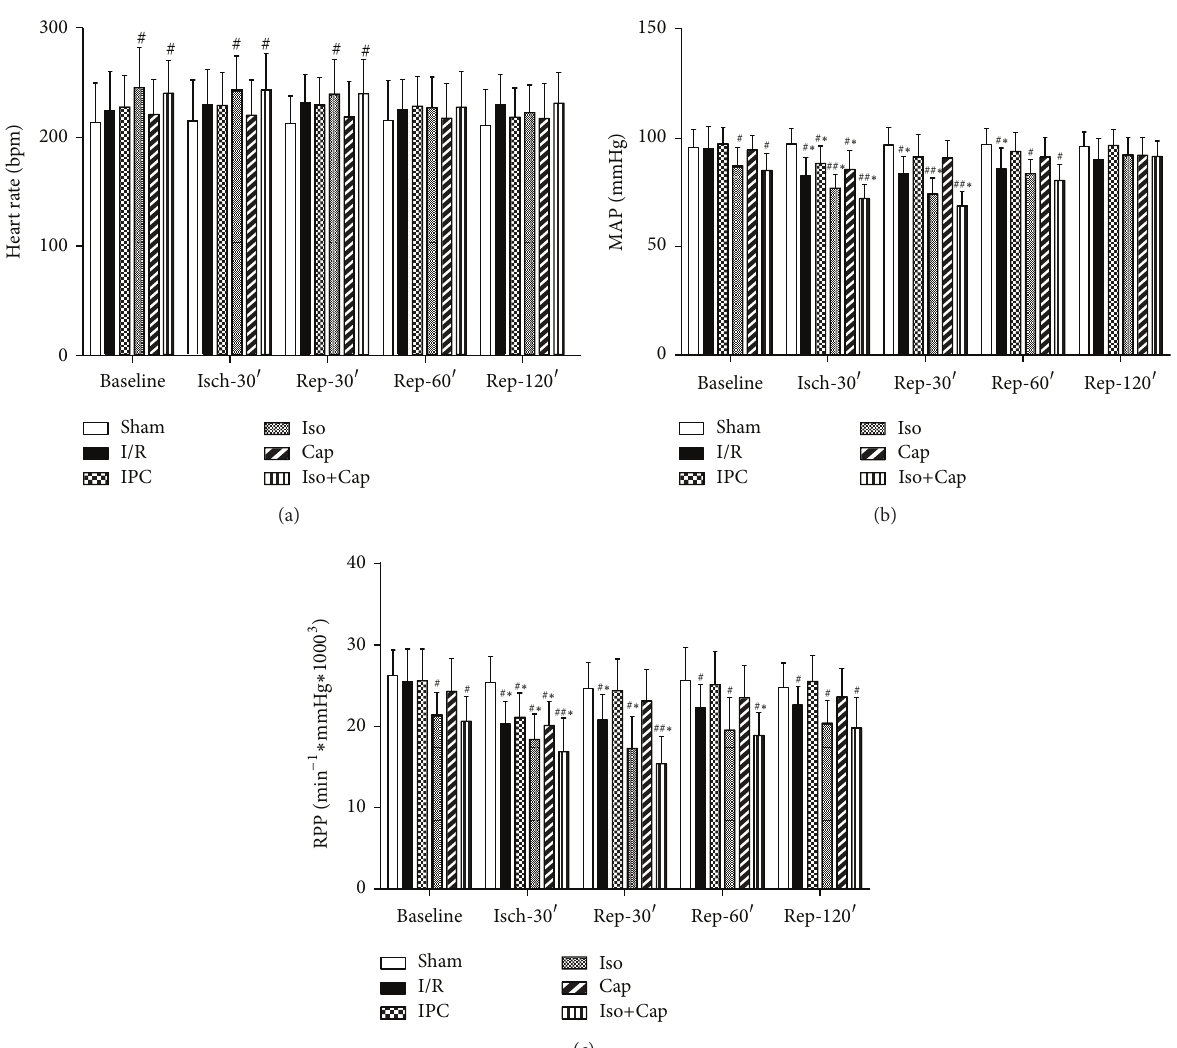
proinflammatory cytokines release, and myocardial